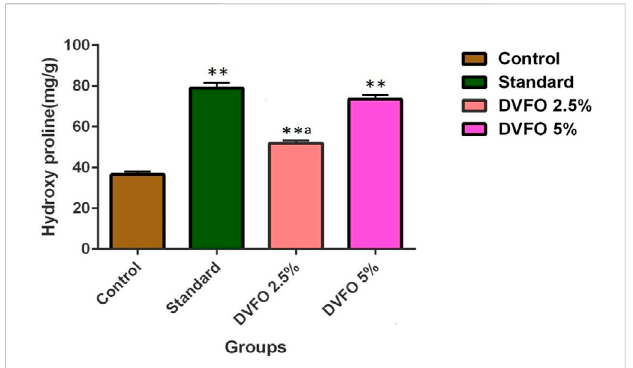
FIGURE 4 Effect of DVFO on hydroxyproline content. Values are expressed as Mean ± SD. Statistical analysis was done by Kruskal – Wallis followed by Mann-Whitney U test. Statistical signi fi cance: ** p < 0.01 vs. Control, a p < 0.05 vs. Povidone iodine-treated